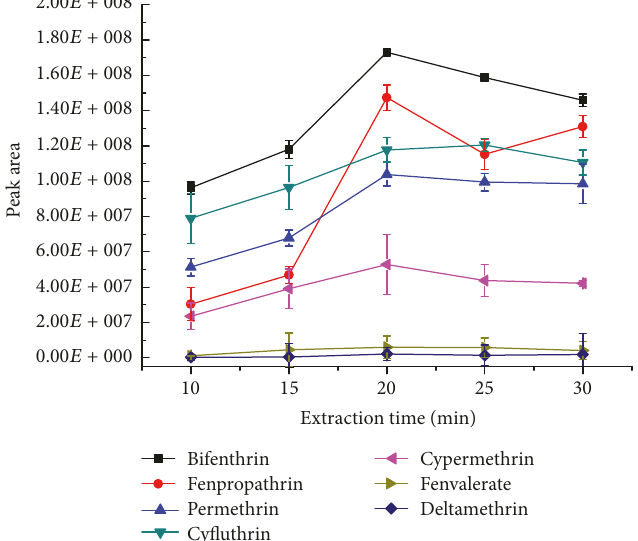
Figure 3: The effect of the extraction time on the extraction efficiency ( 𝑛 = 3 ). The standard mixture concentration: 20 ng mL −1 , stirring rate: 750 rpm, desorption temperature: 280 ∘ C, and desorption time: 5